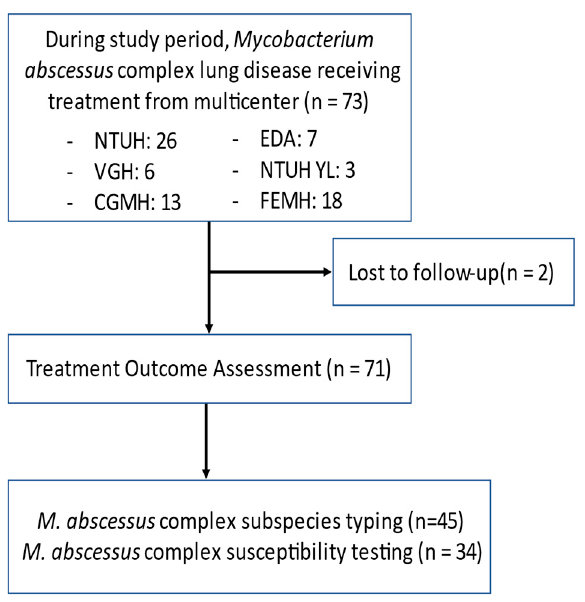
Figure 1. Flow diagram of participant enrollment. Abbreviations: CGMH, Chang Gung Memorial